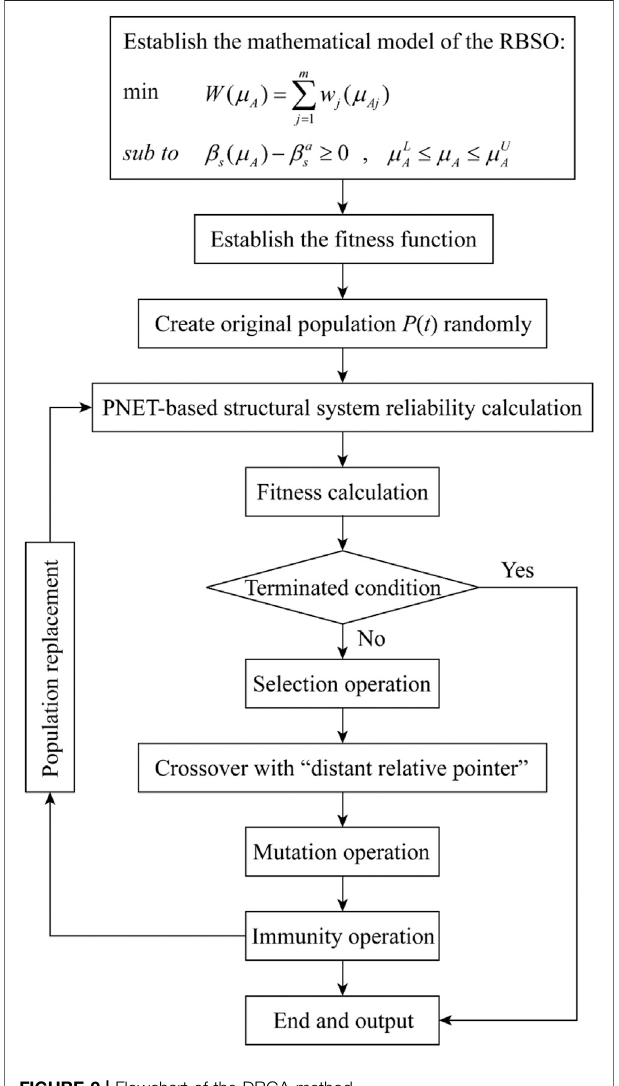
FIGURE 2 | Flowchart of the DRGA method.